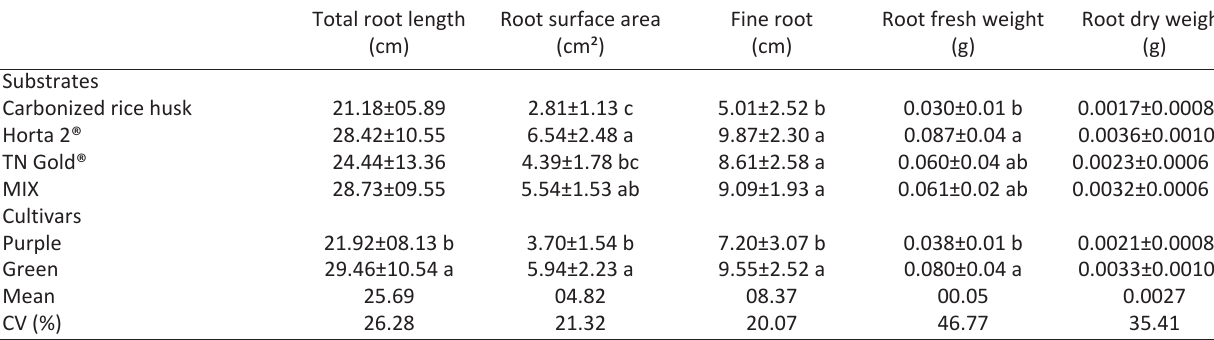
mixture.MIX= Fig. 5 - Quality of the development of lettuce seedlings produ- ced in four substrates. Values are means ± standard deviation. Different letters above columns indicate significant differences by the Tukey test (P≤0.05, n= 3). CRH= Carbonized rice hull; HOR= Horta 2®; TNG= TN Gold®; MIX=